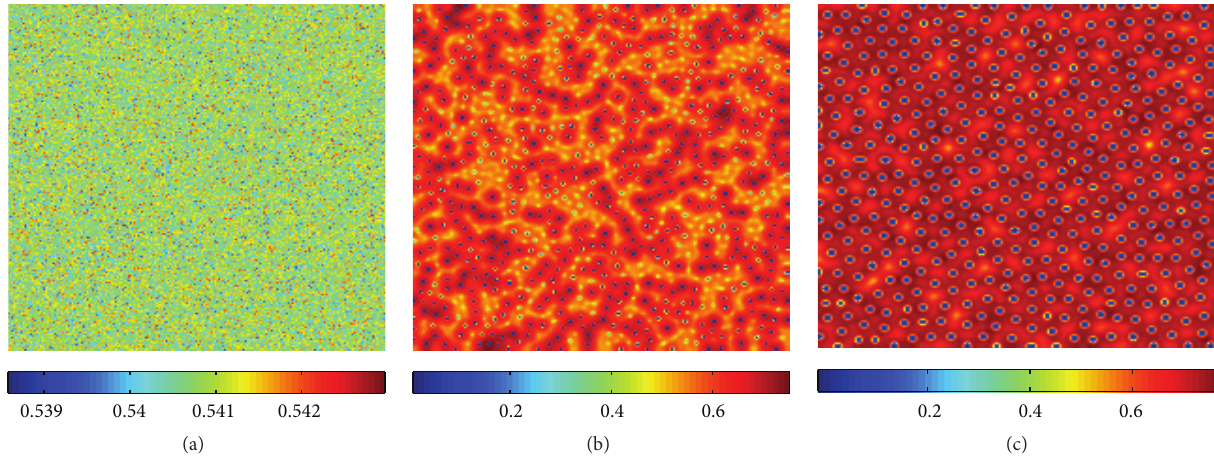
Figure 3: Patterns obtained with system (2) using the following parameters: 𝐾 = 0.205 , 𝑢 1 = 0.7 , 𝑟 1 = 0.2 , 𝑢 2 = 0.382 , 𝛽 1 = 0.21 , 𝛽 2 = = 0.1 , V = 0.09 , V = 0.013 , 𝐷 = 0.04 , and 𝐷 0.2428 , 𝛽 3 1 2 11 (b) 1000, and (c)